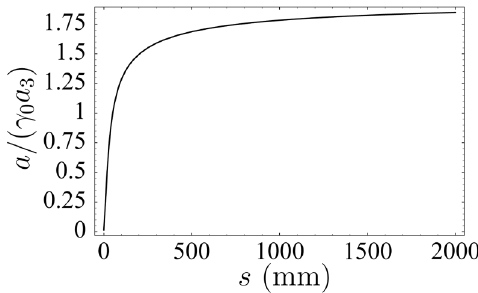
(cid:2) x (cid:3) =g (cid:2) x (cid:3) (dashed line) 0 1 (cid:2) x (cid:3) = 2 (solid line) are shown as a 0 (cid:3) . a 0 3